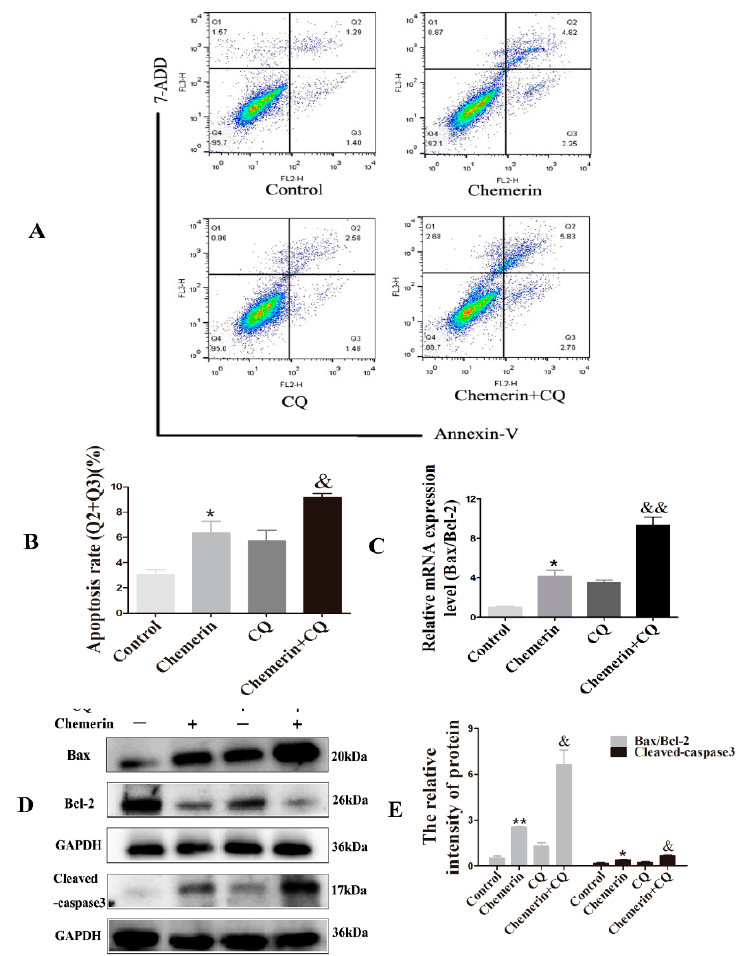
Figure 5. Inhibition of autophagy promotes apoptosis induced by Chemerin in BMECs. Cells were incubated in CQ-containing medium for 2 h before exposuring to the medium with 0.1